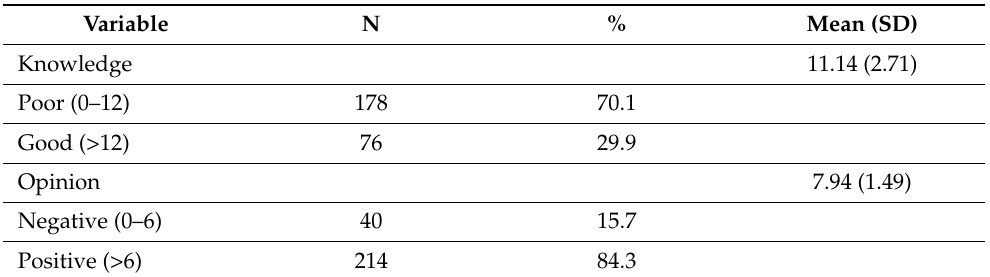
Table 3. Knowledge and opinions’ scores of participating dentists about oral cancer prevention and oral mucosal screening ( n =